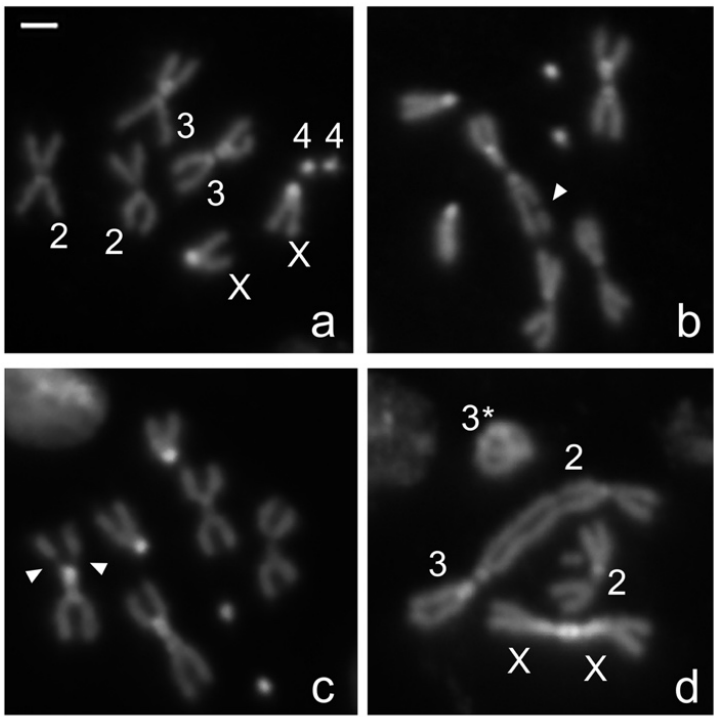
Figure 1. IR-induced CBs and TFs in DAPI-stained larval neuroblasts. ( a ) Examples of IR-induced CBs and TFs in third instar larvae neuroblasts scored for this study: ( a ) wild-type Drosophila melanogaster female metaphase, ( b – d ) examples of metaphases showing ( b ) autosomal chromatid deletion (arrow), ( c ) autosomal isochromosome deletion (arrows), and ( d ) TFs giving rise to a ring chromosome involving the chromosome 3 (asterisk), a chromosome 2-chromosome 3 dicentric chromosomes, and a X-X dicentric chromosome. Bright DAPI-stained chromosome regions refer to the centromeric and pericentromeric portions of the two major autosomes [23].